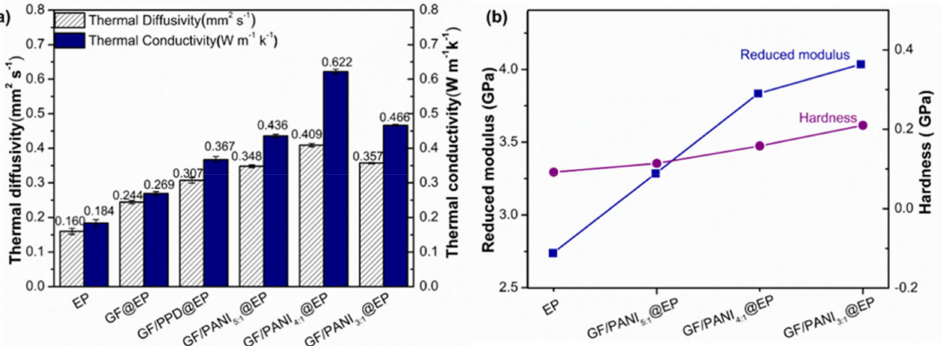
Figure 7. ( a ) The thermal conductivity ( κ ) and ( b ) The hardness and reduced modulus of the EP, GF/PANI 5:1 @EP, GF/PANI 4:1 @EP, GF/PANI 3:1 @EP